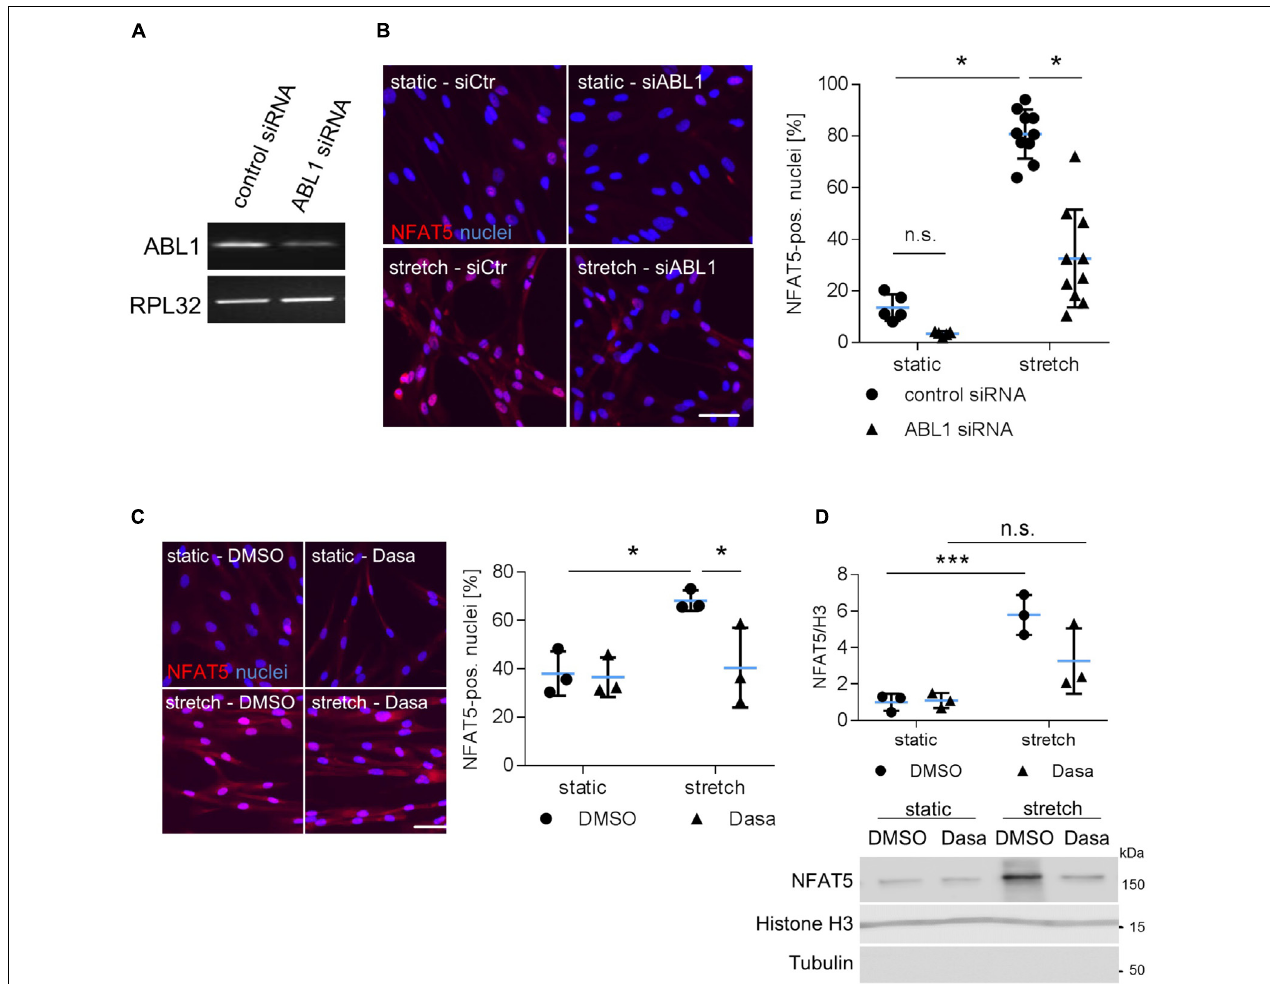
FIGURE 5 | Analysis of nuclear translocation of NFAT5 upon knockdown of ABL1. HUASMCs were transfected with control (scrambled) siRNA or ABL1-specific siRNA (ABL1 Silencer R (cid:13) Select Validated siRNA, S864, Ambion, Applied Biosystem, Thermo Fisher Scientific, Darmstadt, Germany) which decreased ABL1 expression by ∼ 50% as evidenced by PCR analyses (A) . Transfected HUASMCs were exposed to biomechanical stretch for 24 h. NFAT5-specific immunofluorescence was detected by automated image analysis to assess the percentage of NFAT5-positive nuclei ( B , ∗ p < 0.05, one-way ANOVA and Tukey post-test; control siRNA n = 5, ABL1 siRNA n = 10). Dasatinib (inhibitor of BCR-ABL kinases, 5 nM) treatment of stretch-stimulated HUASMCs decreased the number of NFAT5 positive nuclei as evidenced by automated immunofluorescence analyses ( C , ∗ p < 0.05, one-way ANOVA and Tukey post-test, n = 3). Additionally, HUASMCs were treated with Dasatinib (Dasa; 5 nM) or DMSO for 1 h and exposed to biomechanical stretch for 24 h. Accumulation of NFAT5 in the nucleus was determined in nuclear lysates by immunoblot techniques with (nuclear) histone H3 as loading marker ( D , ∗∗∗ p < 0.05, n.s.: not significant, one-way ANOVA and Tukey post-test, n =